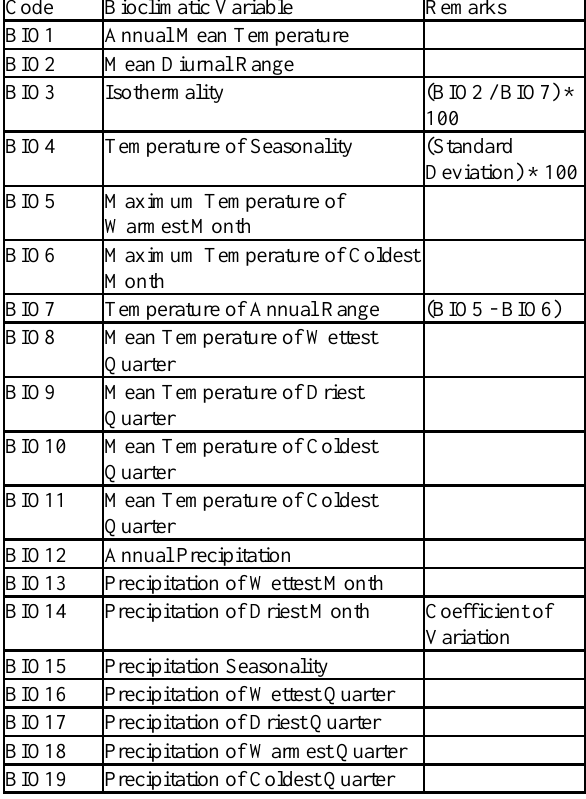
Table 2. Bioclimatic